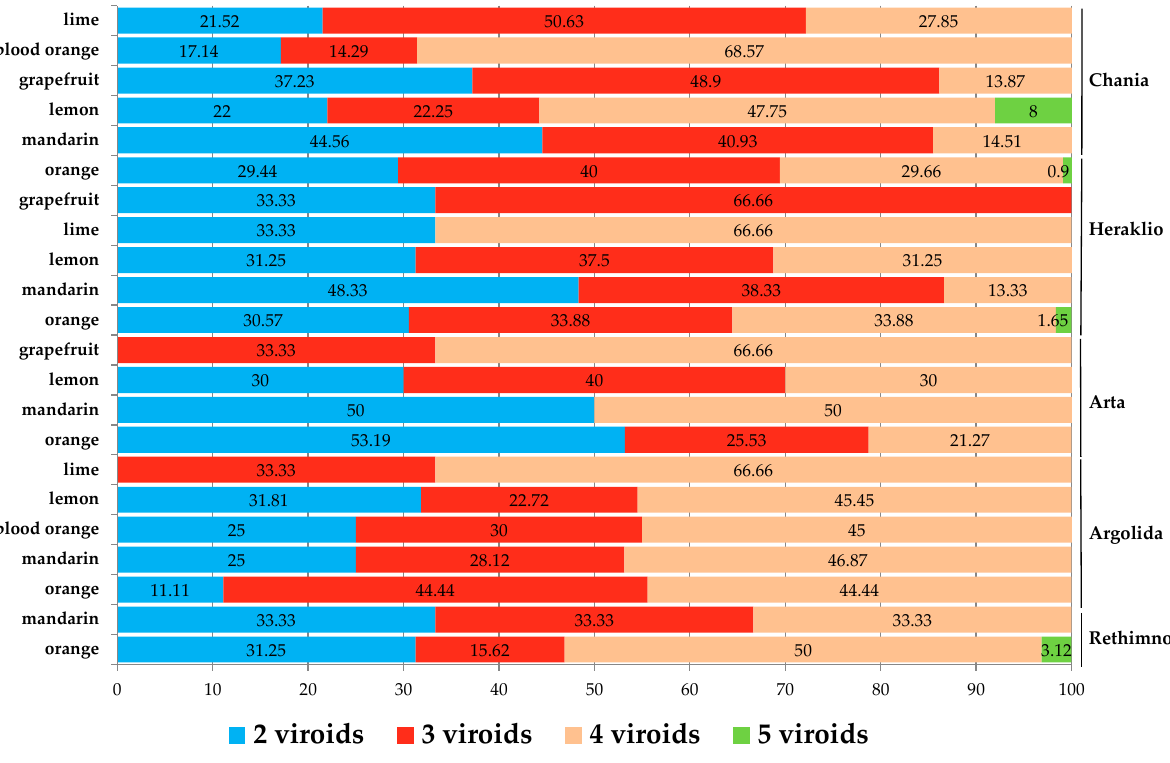
Figure 4. Frequency results (%) of the different mixed infection types (with two, three, four or five viroids) in each surveyed host population in the five districts in Greece.